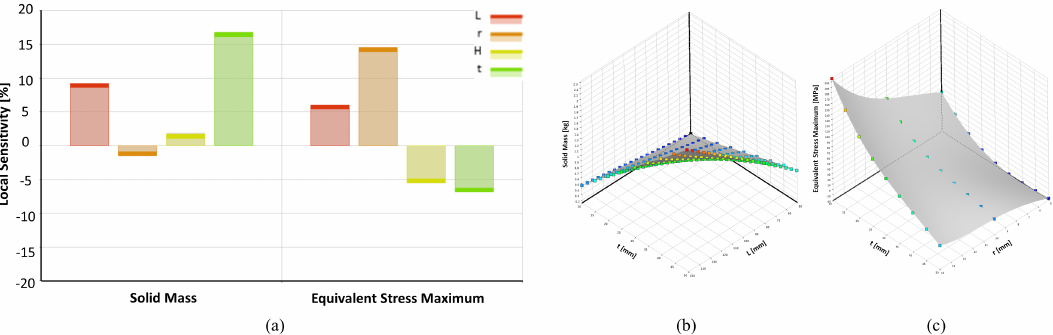
Figure 11. ( a ) Sensitivity analysis of the Hollow Plate, ( b ) response surface plot presented the impact of the thickness and length to the mass, and ( c ) response surface plot showed the e ff ect of the thickness and the radius to the maximum equivalent stress.